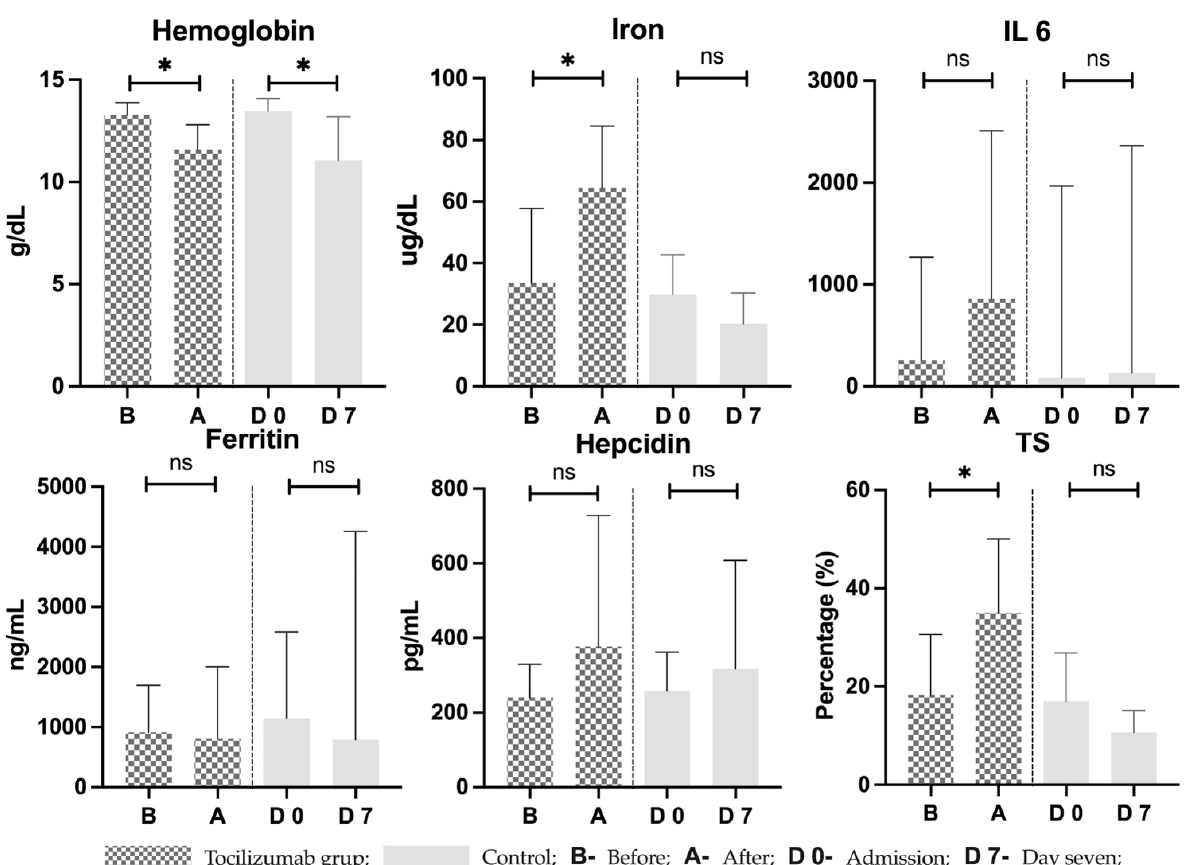
Figure 3. Laboratory parameters in tocilizumab and control groups. B—right before receiving treatment with tocilizumab; A—seven days after treatment with tocilizumab; D 0—day of admission in control group; D 7—day seven after admission in control group; TS = transferrin saturation; IL-6 = interleukin 6; * = statistically significant; ns = statistically non-significant.